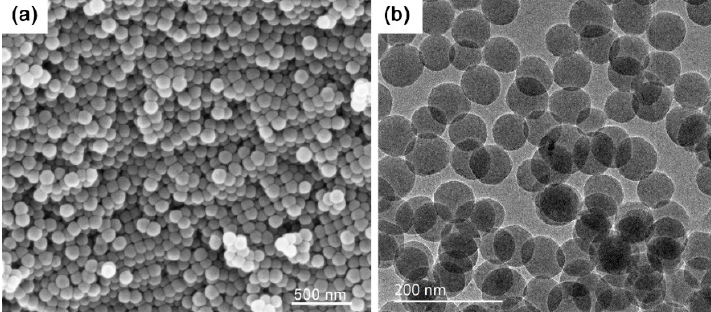
Figure 2. Microstructure of SiO 2 nanospheres: ( a ) SEM image and ( b ) TEM image. The average size in diameter was ~76 nm.